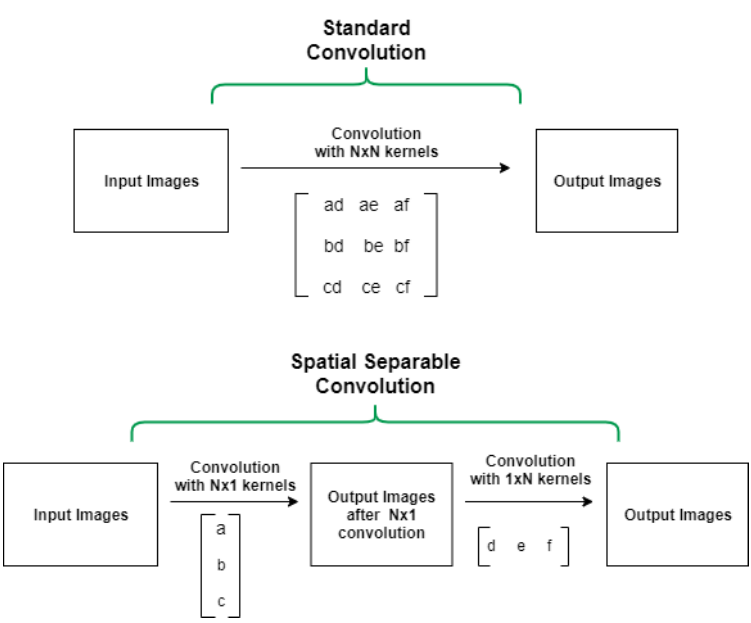
Figure 4. Standard convolution versus spatial separable convolution.